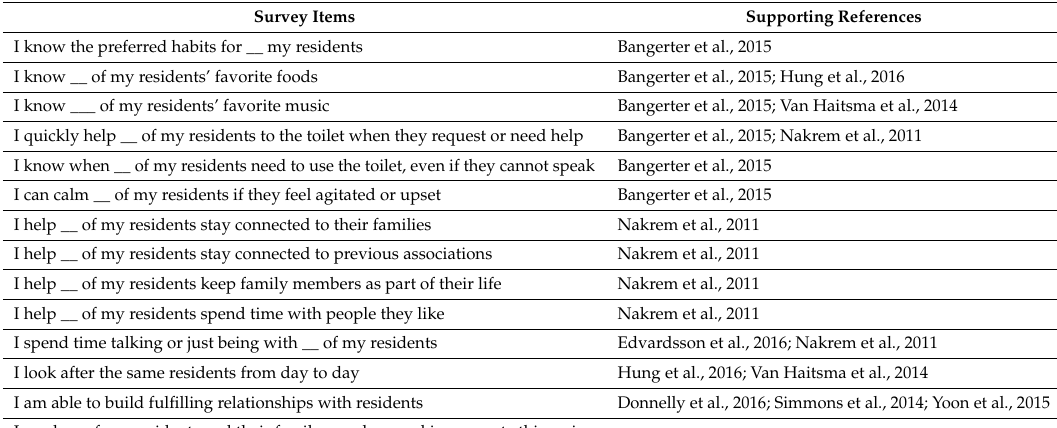
Table 2. Literature Supporting Team Member Perspectives of Person-Centered Care Survey